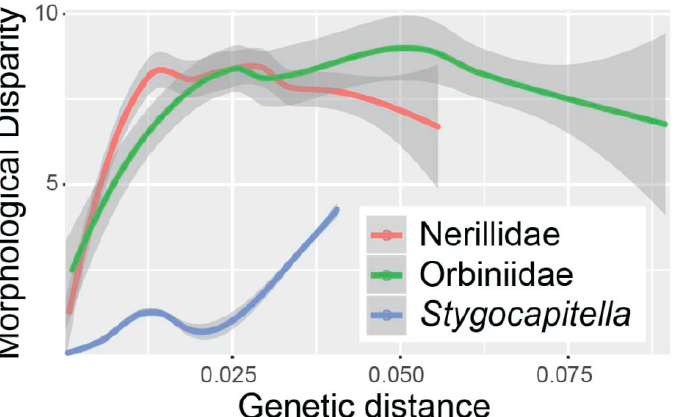
Figure 4. A simplified re-drawing of Figure 5C of Cerca et al. [47]. The plot shows the relationship of morphological disparity measured by pairwise MMD indices in relation to genetic distance measured by pairwise genetic distances of the nuclear 18S rRNA marker. The values for Stygocapitella are compared to the sistergroup of Parergodrilidae, Orbiniidae, and another interstitial annelid group, Nerillidae. The grey area indicates the 95% confidence interval of the fit (line) to the data points (not